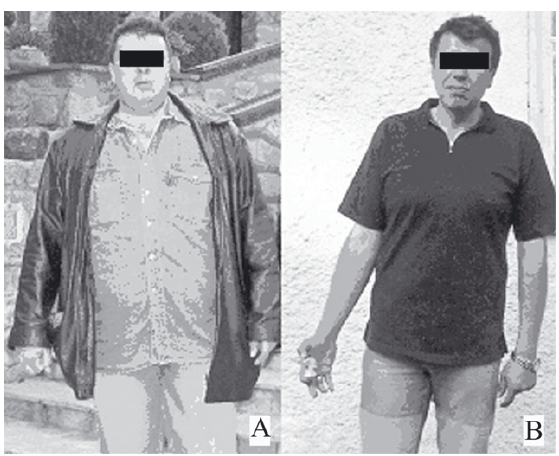
Figure 1. A. The patient at admission. B. The same healthy man